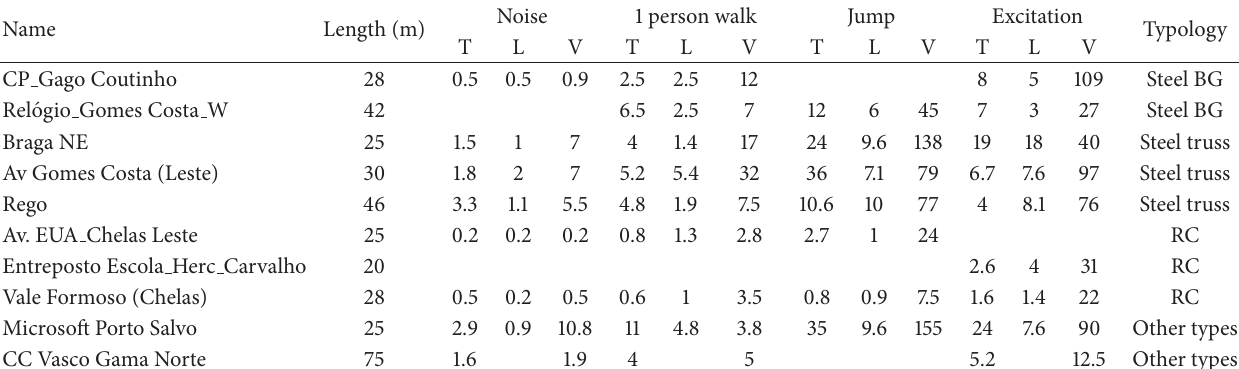
Table 3: Amplitude values in mg of the measured maximum motion at mid-span for a group of 10 footbridges in the transverse (T), longitudinal (L), and vertical (V) directions.